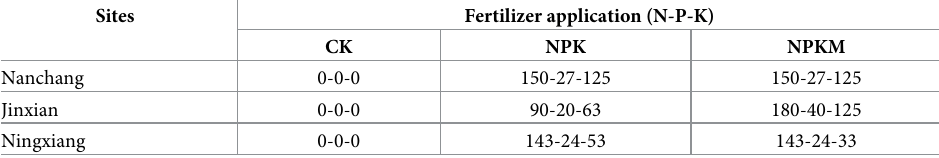
Table 2. Fertilizer input rates (kg ha − 1 ) at the three long-term experimental sites.